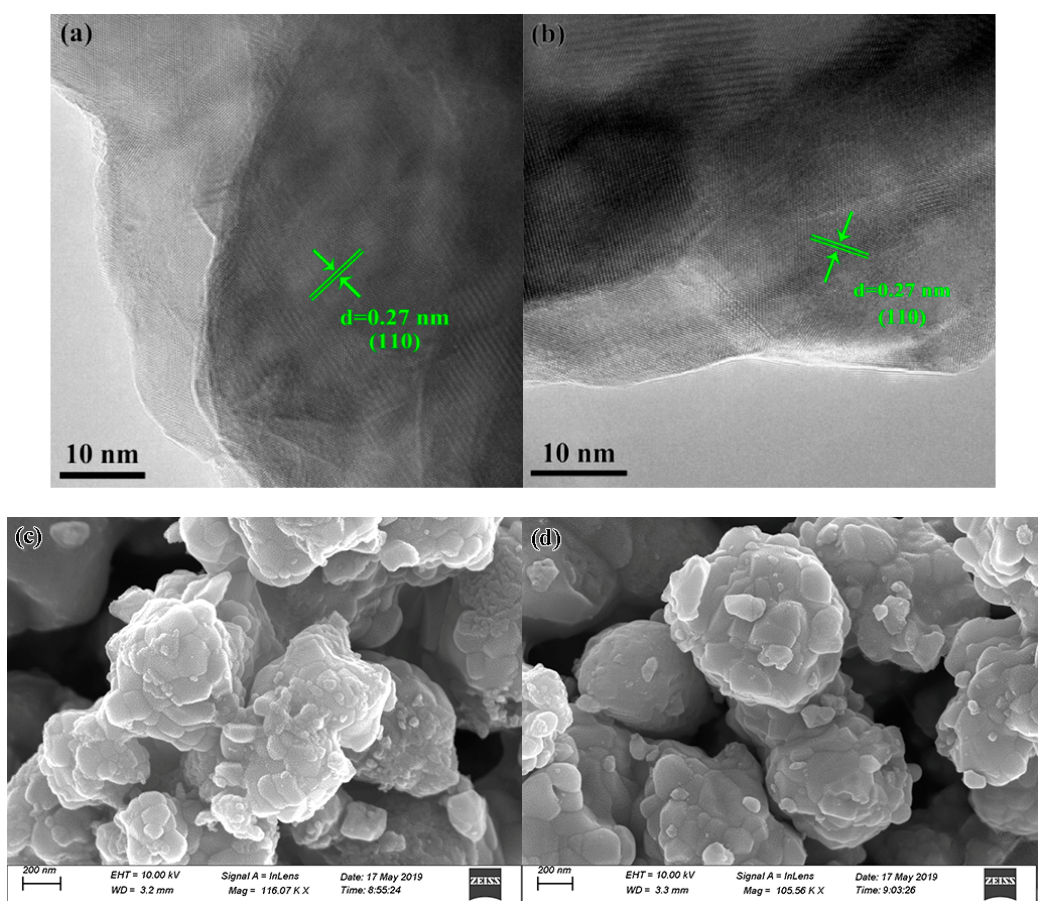
Figure 3. High-resolution TEM images and SEM images of SrTiO 3 ( a , c ) and Q-SrTiO 3 ( b , d ). Table 1. Summary of the XPS data for the SrTiO 3 and Q-SrTiO 3 . Atomic Concentration (%) Atomic Sample